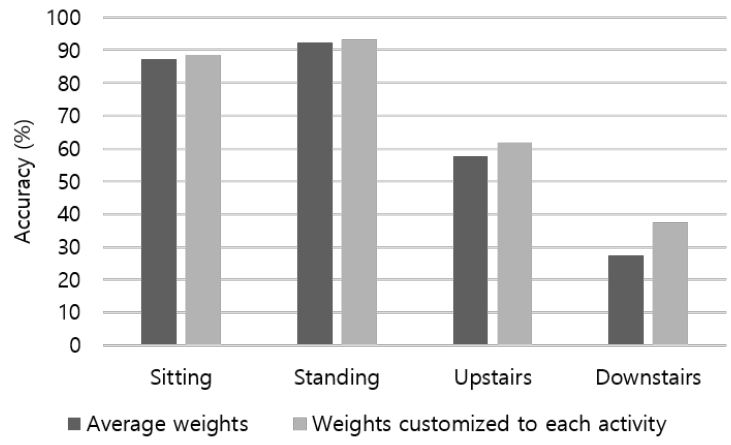
Figure 13. Recognition accuracy increases when applying weights that are customized to each activity.